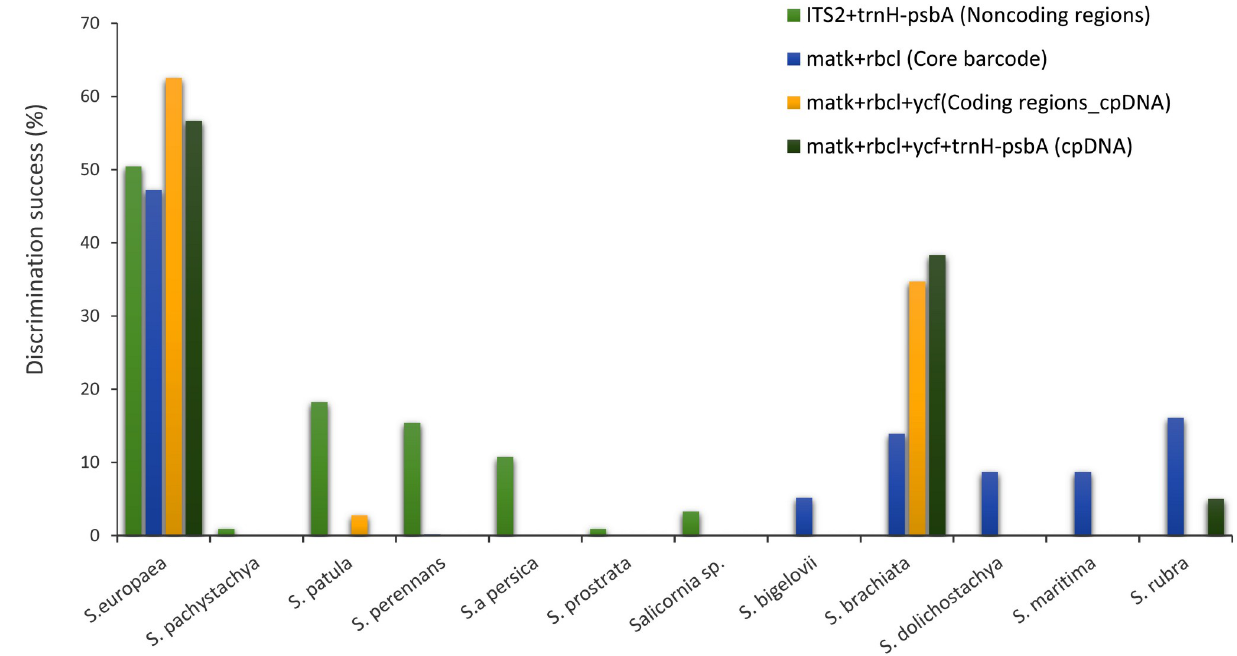
Fig 4. Performances of matK , rbcL , trnH - psb A, ITS2 and ycf in resolving Salicornia species as different non-coding, coding, core and cpDNA